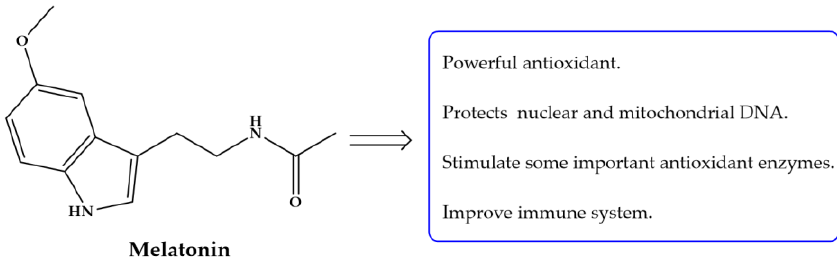
Figure 9. Melatonin (MEL) is a powerful antioxidant with a noteworthy protective action for nuclear and mitochondrial DNA due to efficacy as a radical scavenger. MEL may also stimulate activity of some key enzymes that participate in immunological functions.